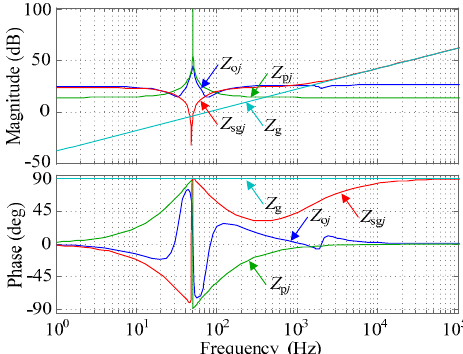
Figure 9. The Bode diagrams of the inverter self-impedance Z o j , parallel virtual impedance Z p j , grid equivalent impedance Z sg j , and grid impedance Z g .